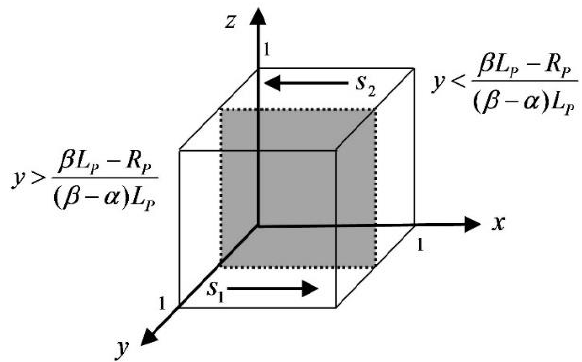
Figure 2. The elderly dynamics trend phase diagram.